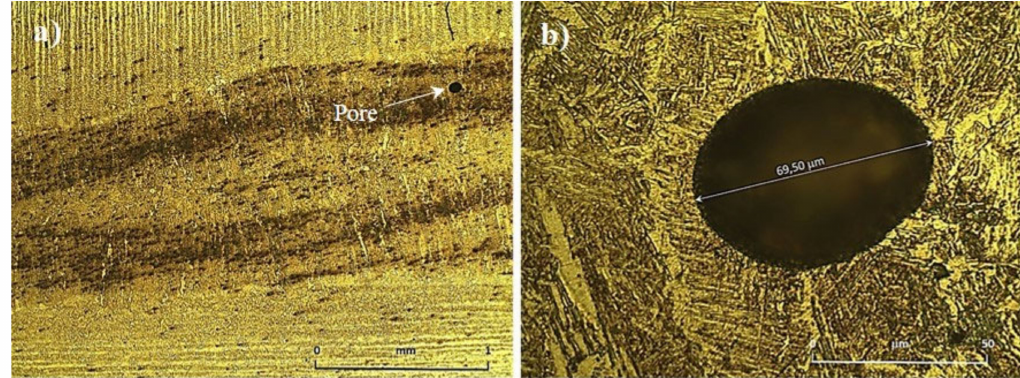
Figure 6. Pore observed at laser fusion zone: ( a ) 50 × magnification ( b ) 1000 ×